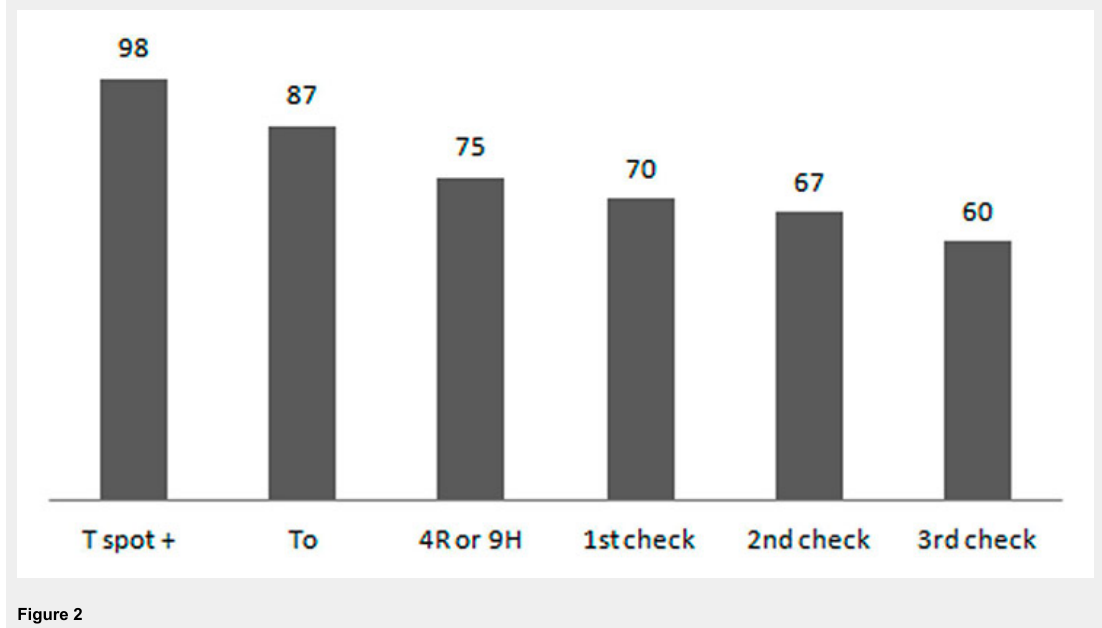
Figure 2 Monthly assessment and drop outs. T spot+: Positive T-SPOT.TB, To: initial examination of the participants, 4R or 9H: Preventive treatment start either four months of rifampicin or nine months of